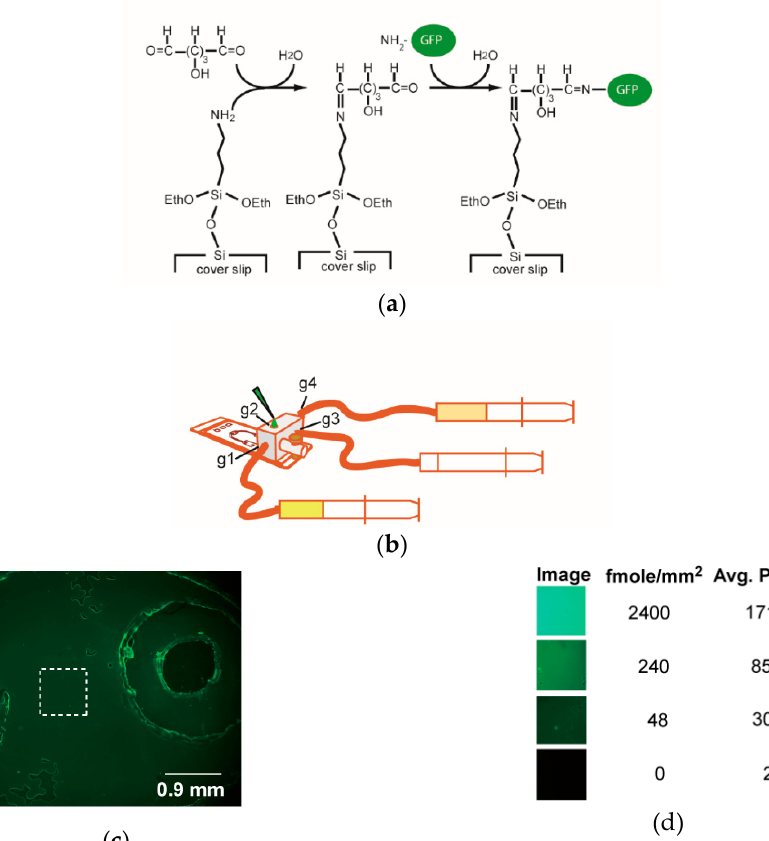
Figure 4. GFP immobilization on the microfluidic chip. ( a ) The chemistry of immobilizing GFP protein on coverslip. Glutaraldehyde reacts with the amino groups of surface silane and GFP protein. ( b ) The setup of microfluidic chip and peripherals for immobilizing GFP. g1 represents gate 1, similarly for g2~g4. ( c ) GFP protein immobilized as revealed by the green fluorescence within the region of interest. The average density of GFP protein within the dash line square is about 50 fmole/mm 2 as compared with those of the standards. ( d ) Semi-quantitation of GFP. To estimate the efficiency of protein immobilization, three aliquots (0.8 µ L) of ‘standard’ solutions with different concentrations of GFP protein (40, 4, and 0.8 µ M) were spotted into three nearby closed cells and sealed in the chip. The fluorescent images of the ‘standard’ cells were taken, and the amount of GFP protein in unit area (fmole/mm 2 ) of those cells were estimated. The image between two closed cells was also taken as 0 GFP. The average pixels of the 8-bit images of the standards were measured by using software ImageJ. Two repeats of device-building and GFP-immobilization yielded similar